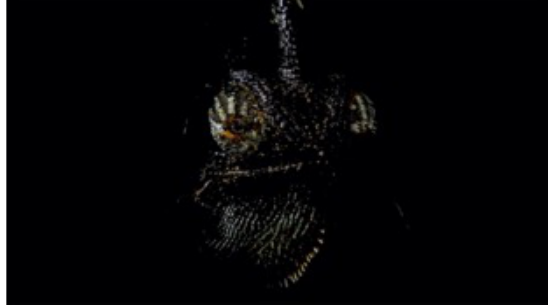
Figure 10 | Printing motion or state changes 5 | MACHINE LEARNING, ETHICS, AND